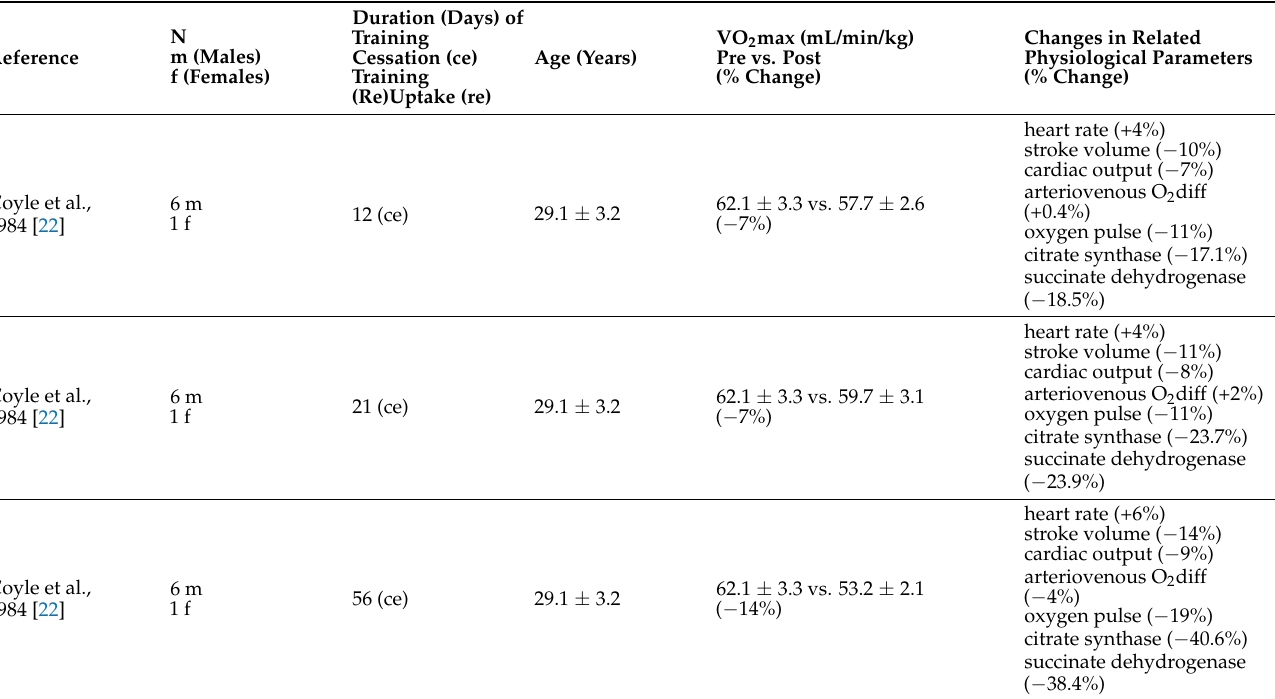
Table 2. Effects of short-term (up to 12 weeks) training cessation and training (re)uptake on VO 2 max and related changes of physiological parameters (cardiorespiratory parameters are maximal val- ues).